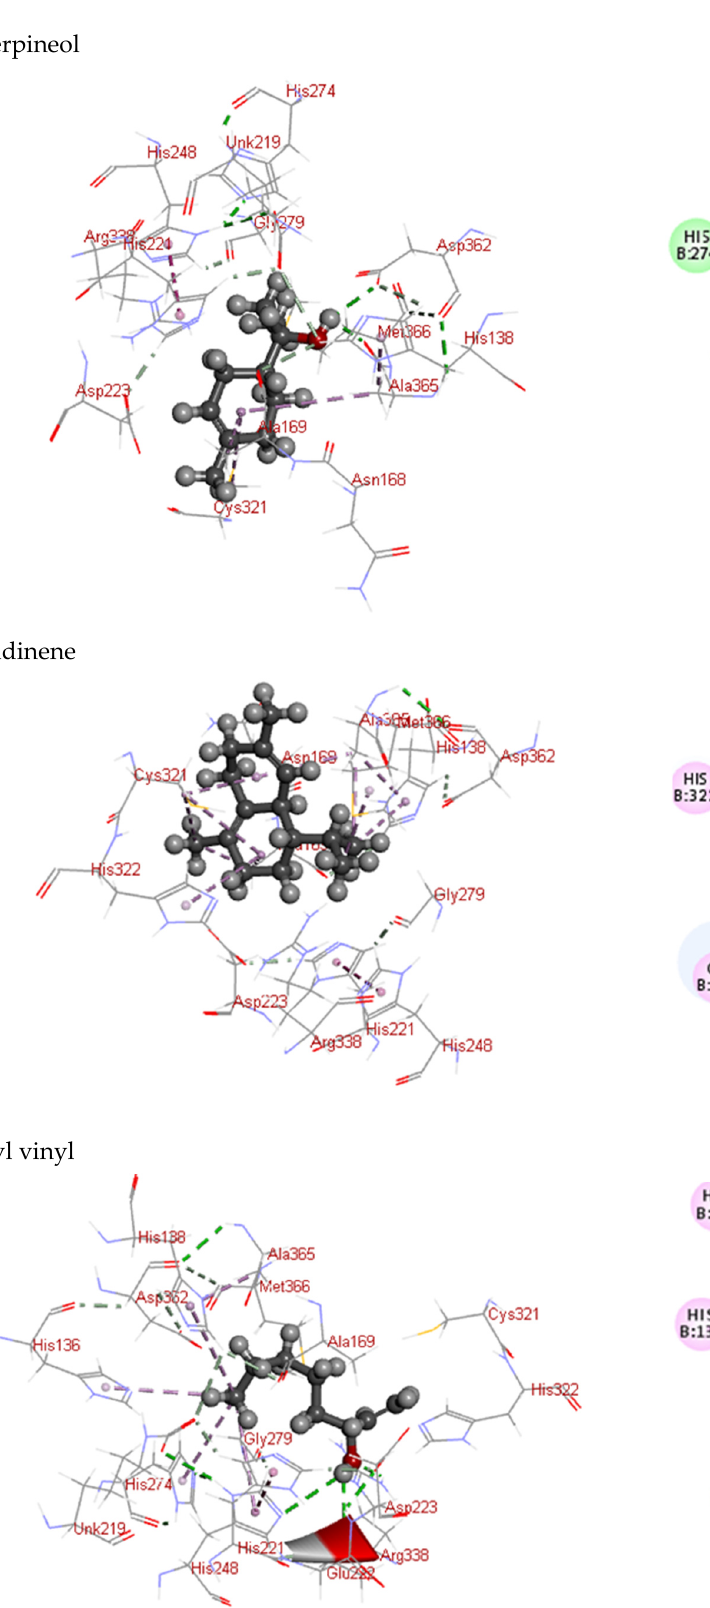
Figure 5. Two-dimensional and three-dimensional binding modes of identified compounds in P. racemosa leaf and stem essential oils within H. pylori urease (1E9Y) active site employing C-docker protocol.